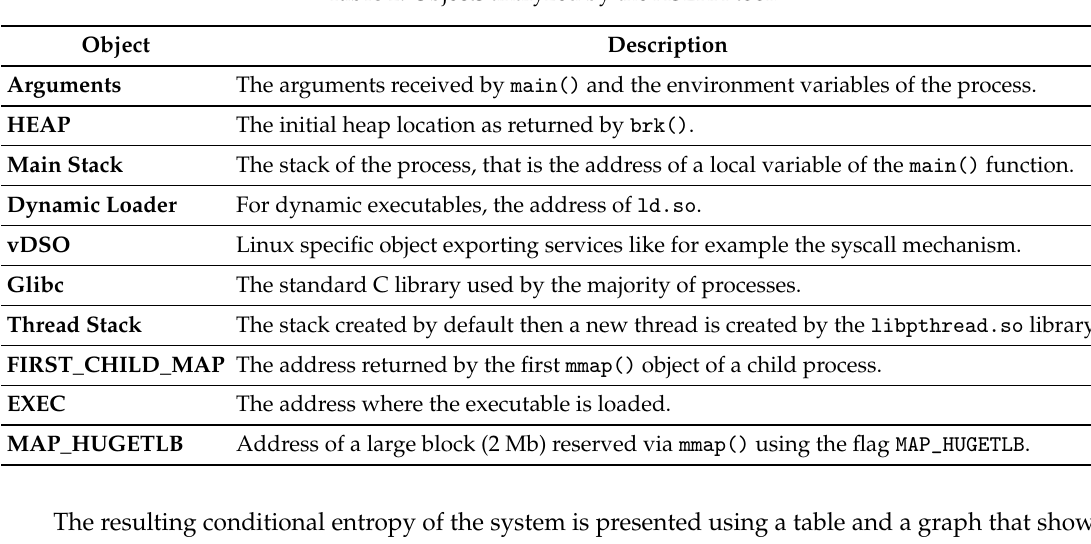
Table 2. Objects analyzed by the ASLRA tool.